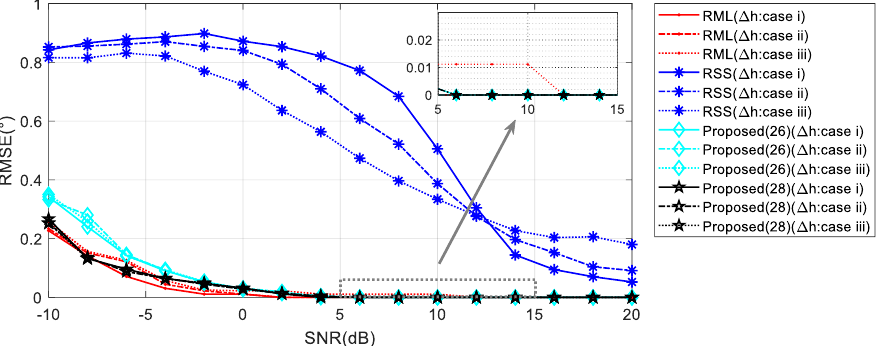
Figure 13. RMSE against input SNR with height fluctuation of reflecting surface when 𝜃 = 1°